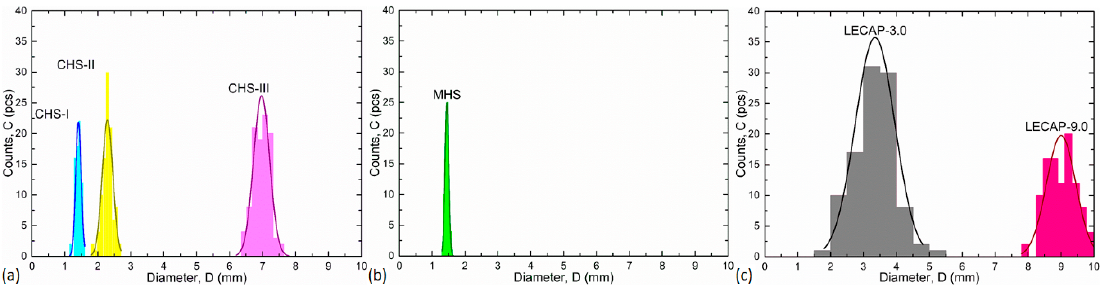
Figure 2. Size ranges and distributions for ( a ) CHS; ( b ) MHS and ( c ) LECAP filler grades.